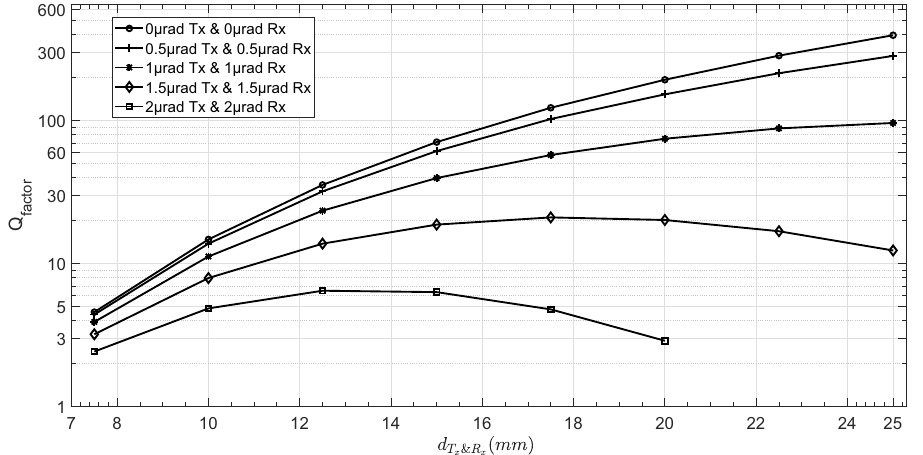
Figure 14: Quality factor ( Q factor ) as a function of both transmitter and receiver optical telescope diameters ( dTx&Rx ( cm )) for di ff erent transmitter and receiver pointing